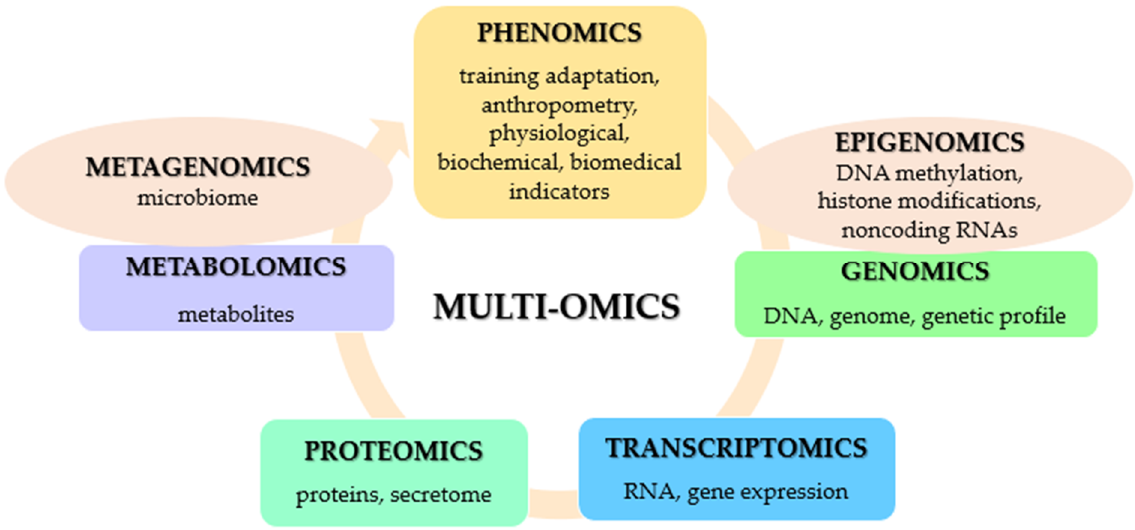
Figure 2. Integrating multiple omics approaches for the study of physical performance traits in ath- letic populations. athletic